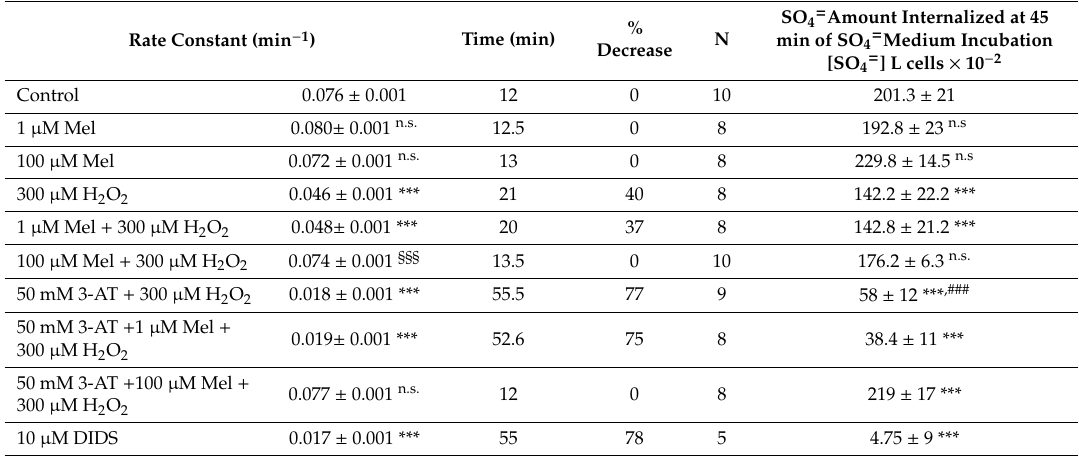
Table 1. Rate constant for SO 4 = uptake and amount of SO 4 = amount internalized by erythrocytes in di ff erent experimental conditions.